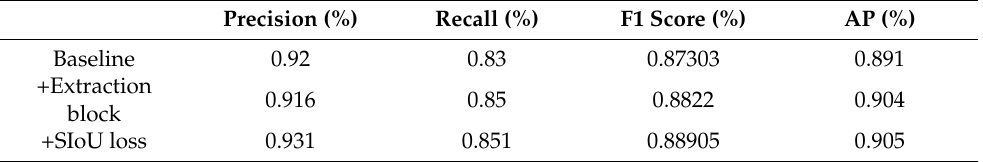
Table 7. Result of ablation experiments in the node detection step.